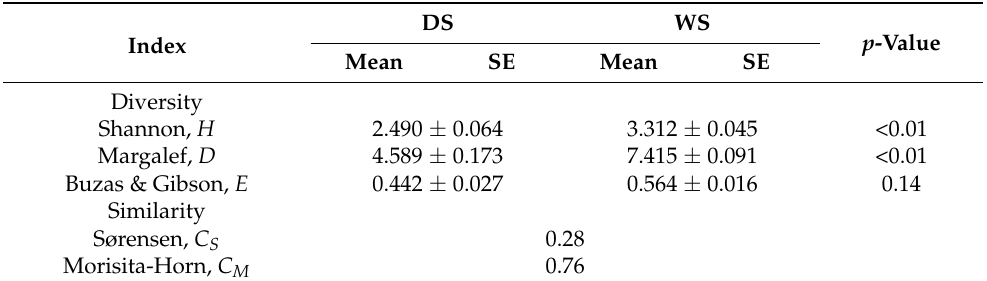
Table 1. Diet of Capreolus capreolus italicus in dry season (DS) and in wet season (WS): diversity and similarity